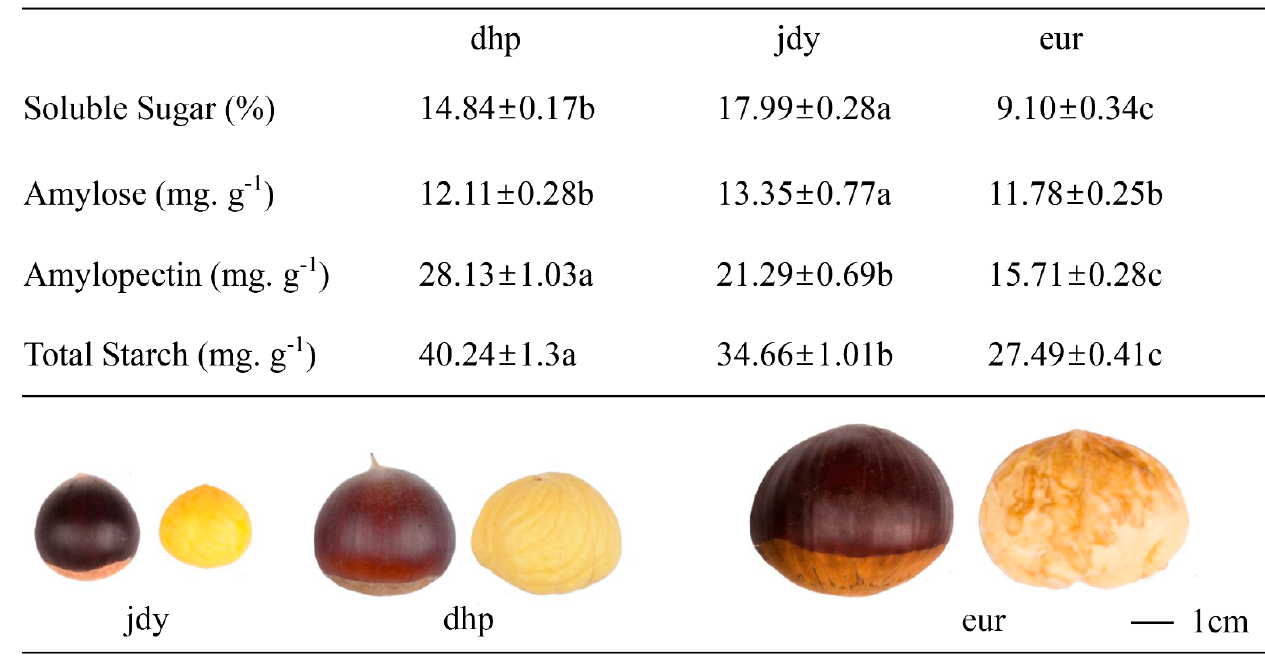
Figure 1. The size, soluble sugar, total starch content, amylose, and amylopectin of three chestnut varieties. Means ± standard error (n = 3). Different letters mean significant differences ( p < 0.05, Duncan’s multiple-range test). Scale bar = 1 cm.